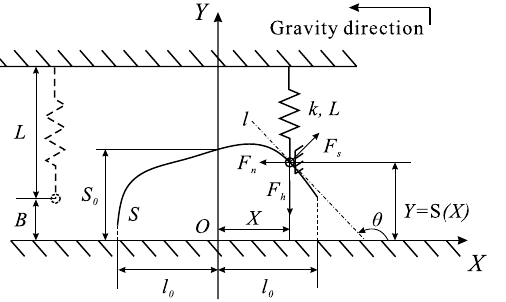
Figure 6. Simplified schematic diagram for the designable